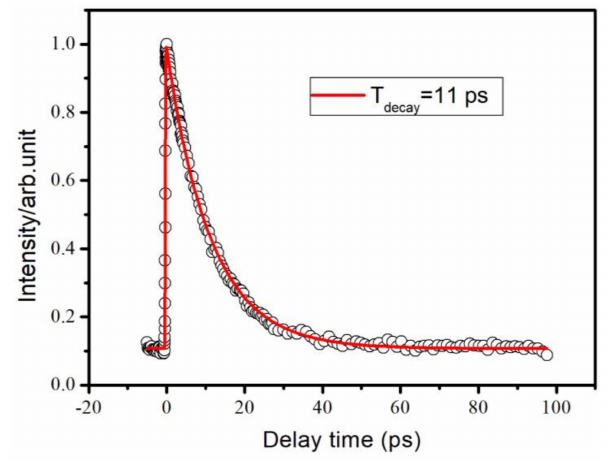
Figure 6. Time decay of the parent ion obtained with 244 nm pump and 400 nm probe detection. The circles are experimental results, and the solid lines are fits with a Gaussian cross-correlation function and a convolution of three exponential decay functions, resulting in different time constants.